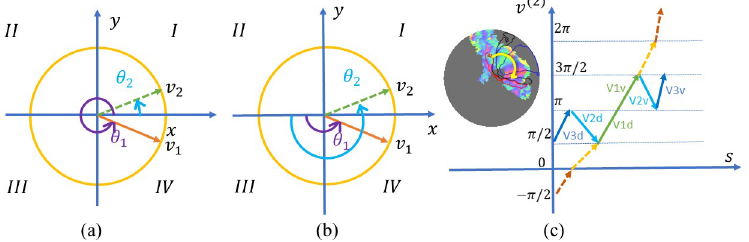
Fig 6. Removing phase jumping and phase reversal. (A, B) Phase jumping and the shift scheme used to remove it. (C) Phase reversal and the transformation used to remove